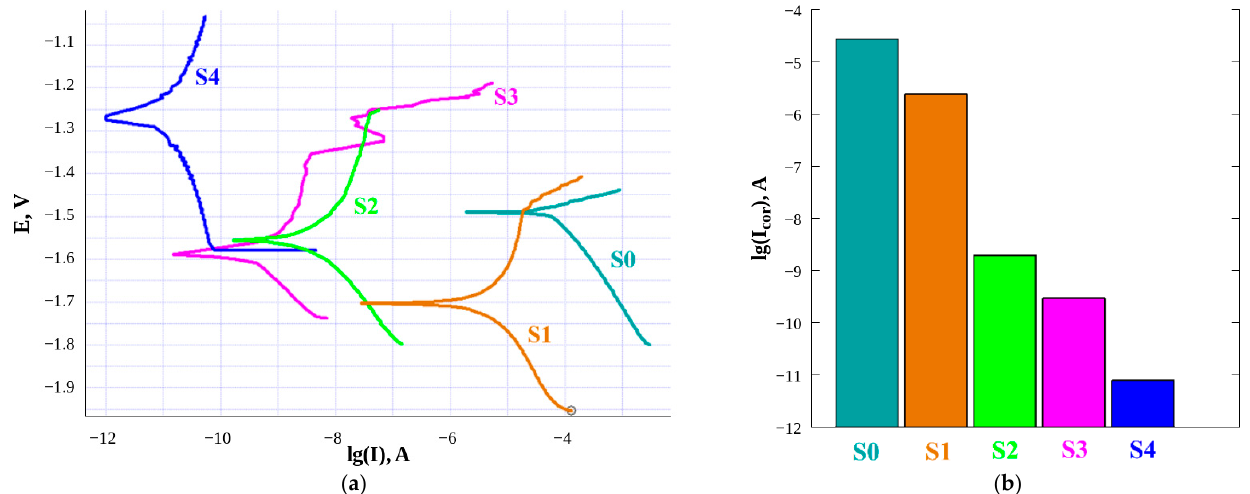
Figure 1. Polarization curves ( a ) and corrosion currents ( b ) registered in 0.5 M NaCl solution for bare Mg sample (S0) and superhydrophobic samples (S1 to S4) fabricated on magnesium alloy surface on the basis of laser treatment with different pulse